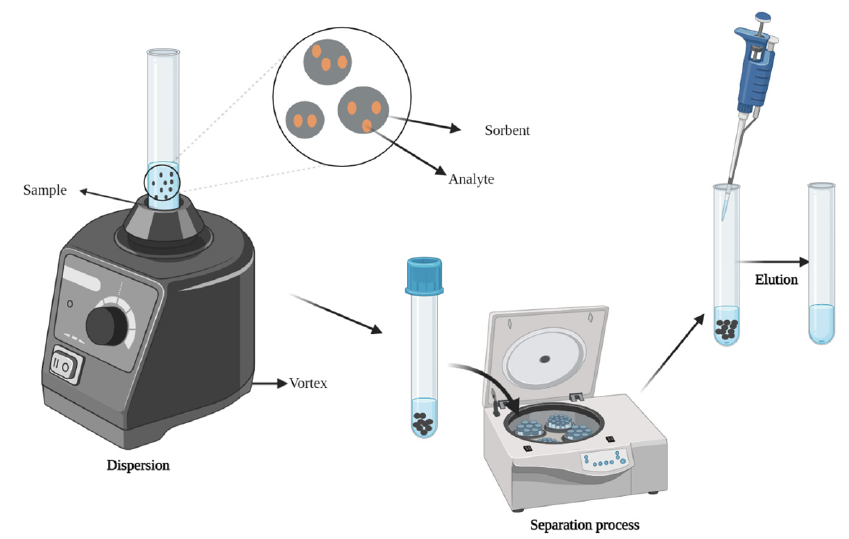
Figure 6. Representation of D-µ-SPE methodology.